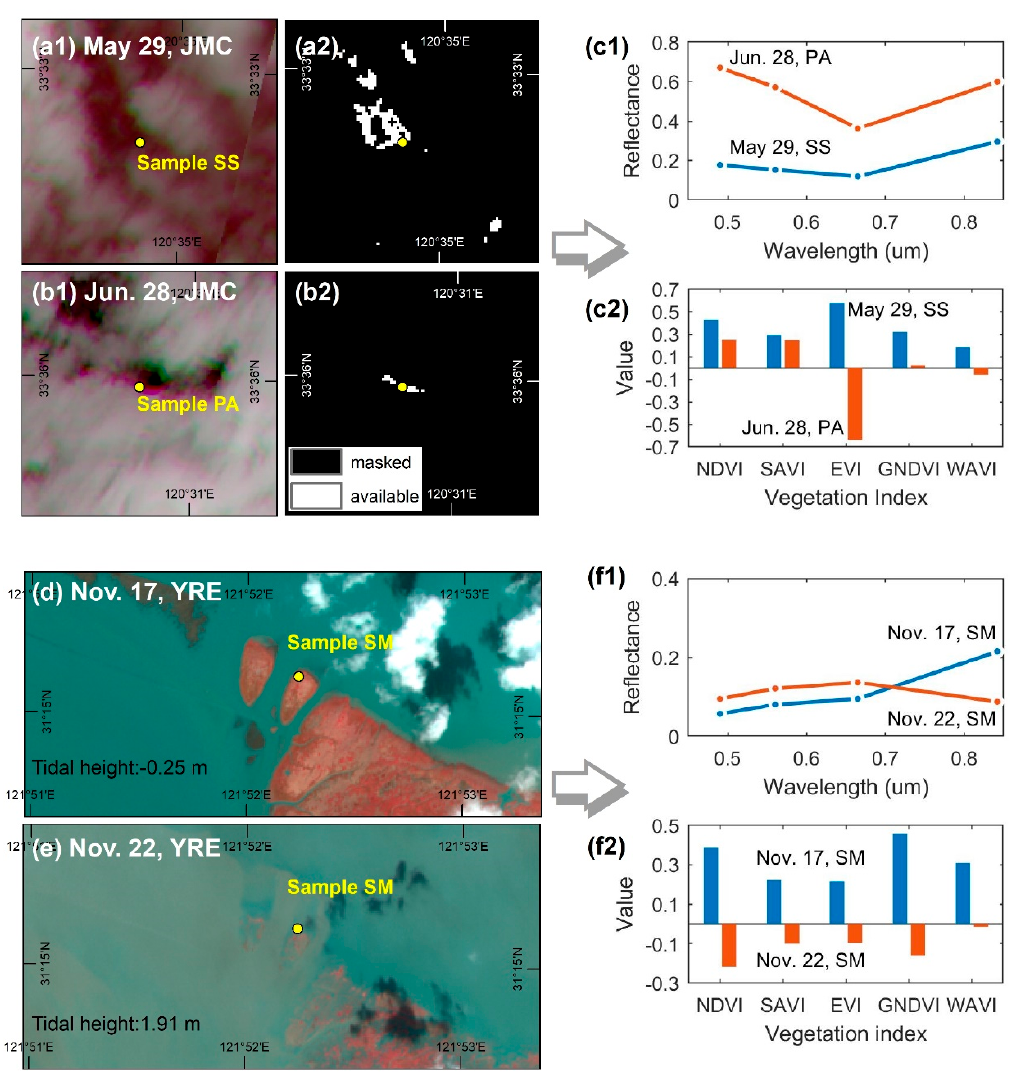
Figure 10. Impacts of coastal environments on the VI time series. Shown are two examples illustrating the errors arising from omitted clouds and shadows: ( a1 – a2 ) two Sentinel-2 MSI images (standard false color) with different acquisition dates on the left, and two corresponding SC maps on the right ( b1 – b2 ); ( c1 ) spectral curves ranging from visible to near-infrared based for the two samples located in pixels containing omitted clouds/shadows; ( c2 ) values for various VIs based on the two samples; ( d – e ) two Sentinel-2 MSI images (standard false color) acquired under different tidal flooding conditions; ( f1 ) spectral curves based on the two samples under different tidal regimes; and ( f2 ) values for various VIs based on the two samples.